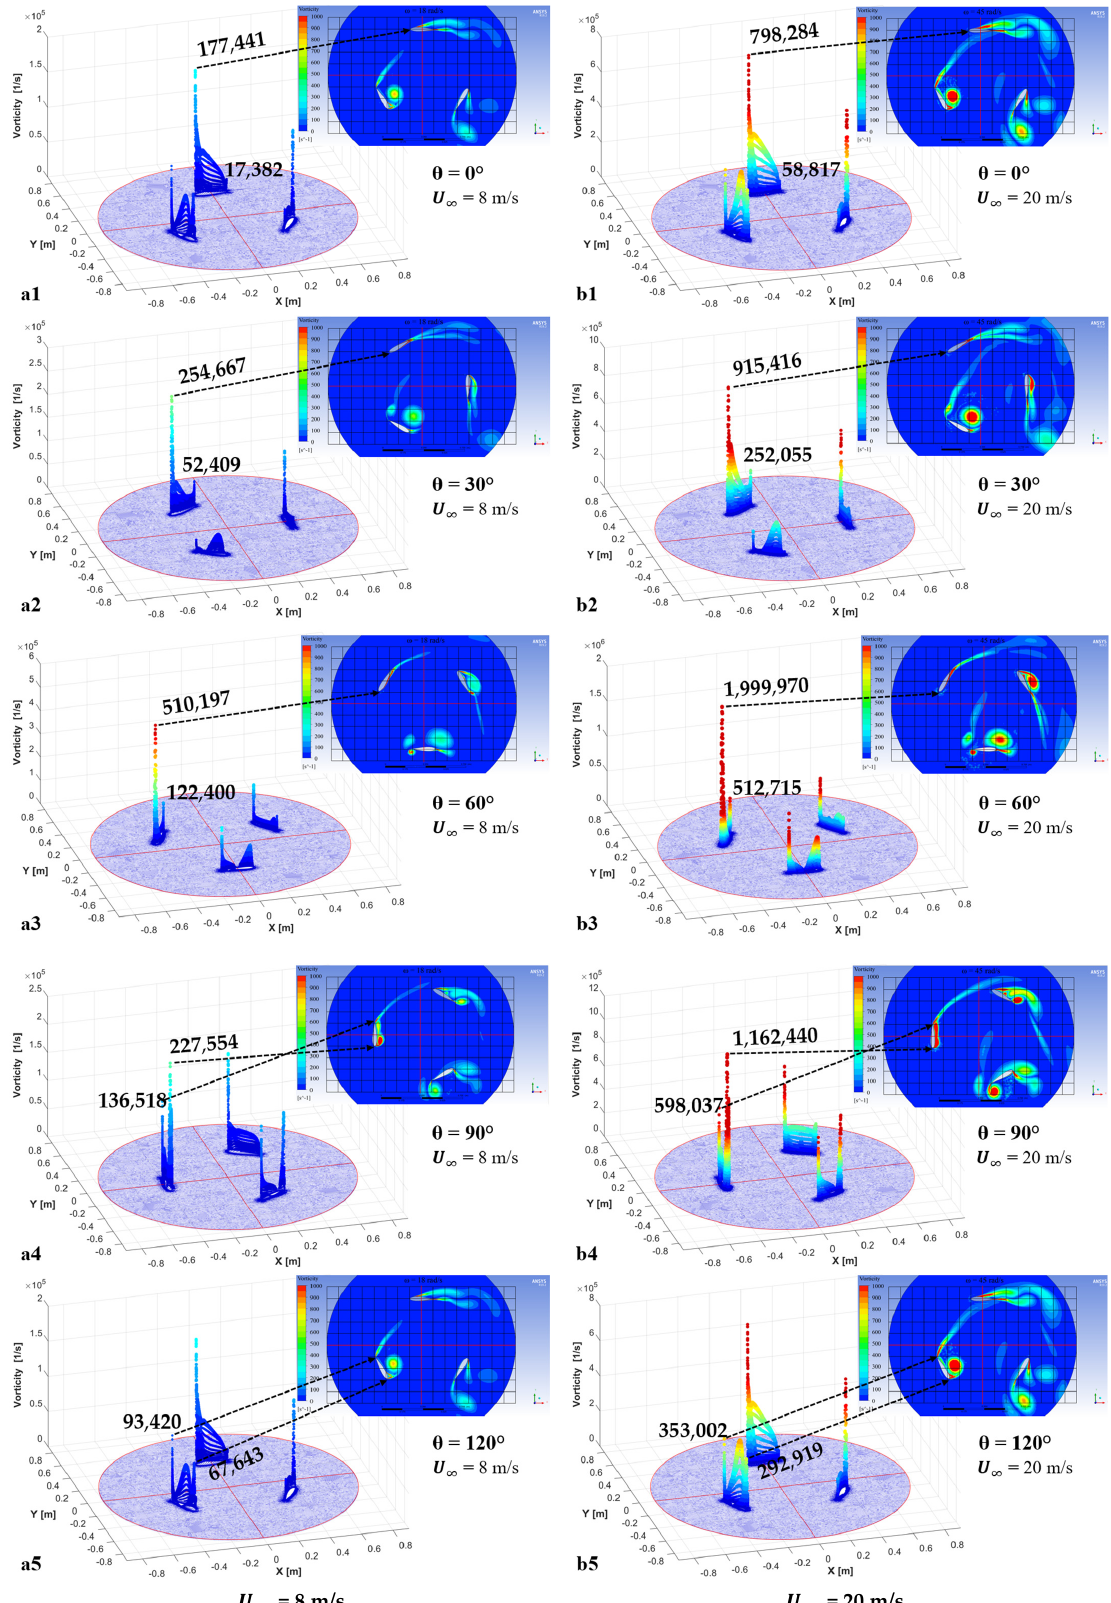
Figure A1. Vorticity Values at LE and TE for Blade 1 at λ = 0.9 for ( a1 – a5 ) U ∞ = 8 m/s and ( b1 – b5 ) U ∞ = 20